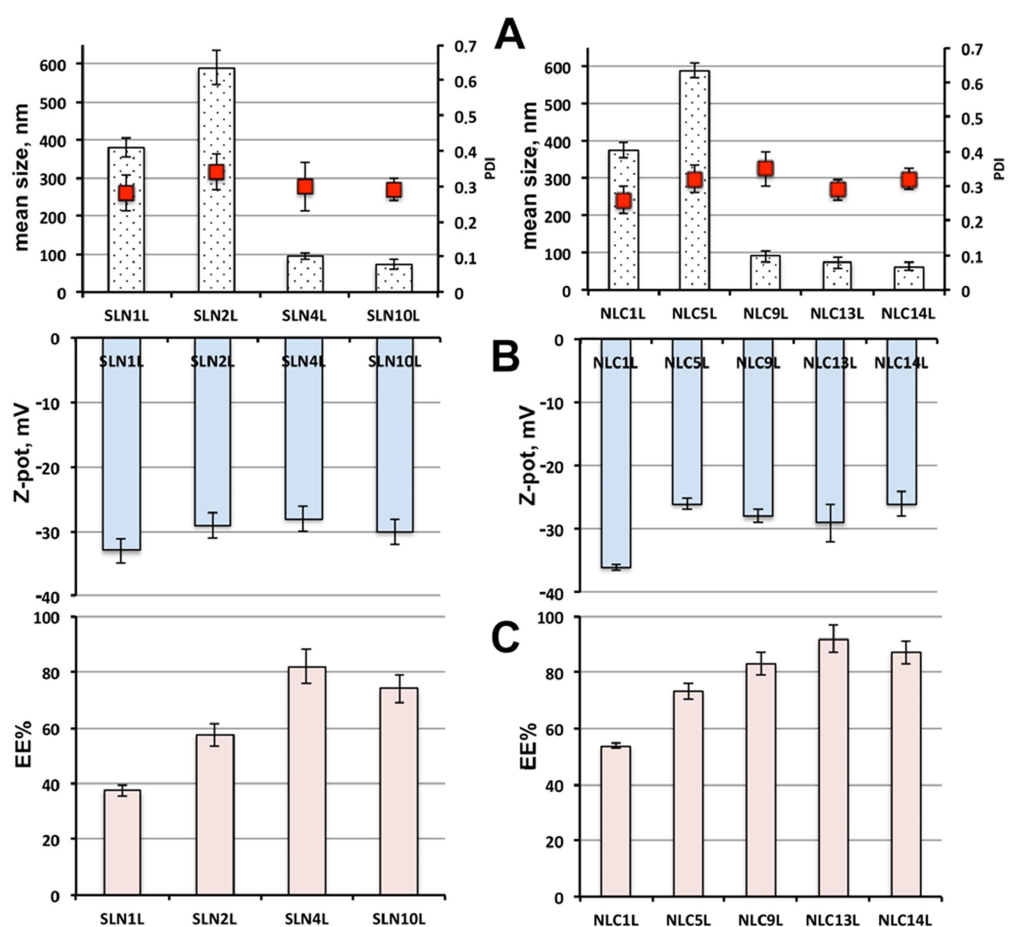
Figure 3. Physicochemical properties of the selected HCT-loaded SLN (left side, SLNnL) and NLC (right side, NLCnL) formulations: mean size and polydispersity index (PDI) ( A ), Zeta potential ( B ) and entrapment efficiency (EE%) ( C ). non-ionic surfactant of 3.5% Gelucire ® 44/14 (SLN 4 L), rather than 1.5% Pluronic ® F68